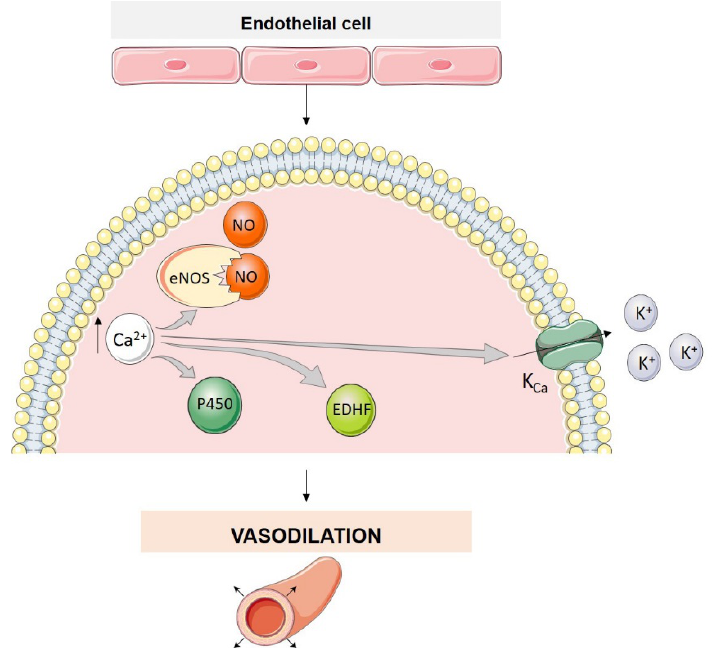
Figure 3. Mechanistic role of Ca 2+ in endothelial cells of pulmonary artery and its vasodilator and vasoconstrictor effect. Ca 2+ -activated K + channels (K Ca ); cytochrome P450 (P450); eNOS